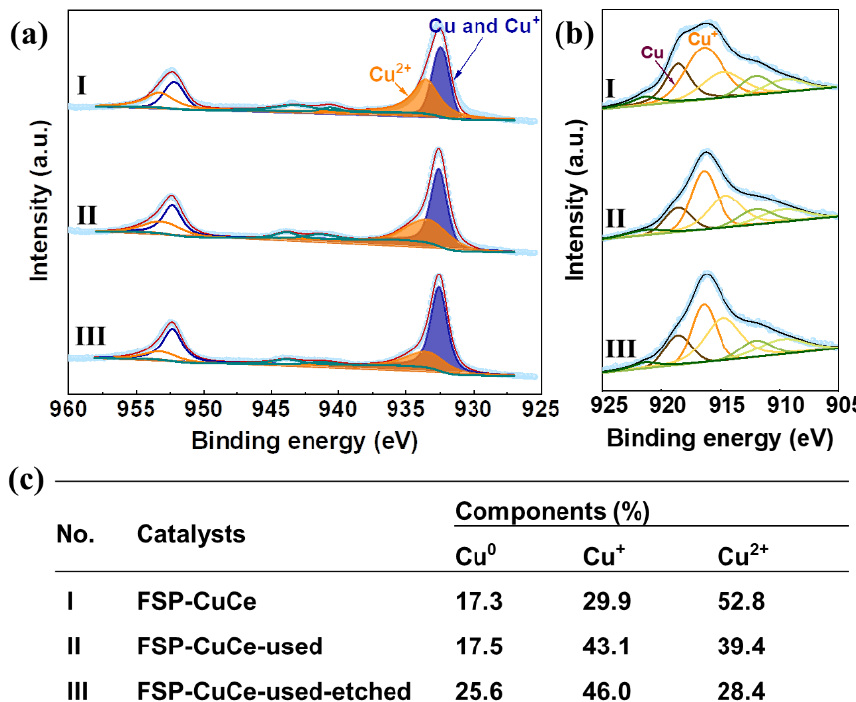
Figure 10. ( a ) XPS spectra of Cu 2 p and ( b ) Auger electron spectroscopy (AES) of Cu LMM over fresh and used FSP-CuCe, as well as the used one with etching treatment. ( c ) Summary of surface compositions of different Cu species derived from XPS spectra.